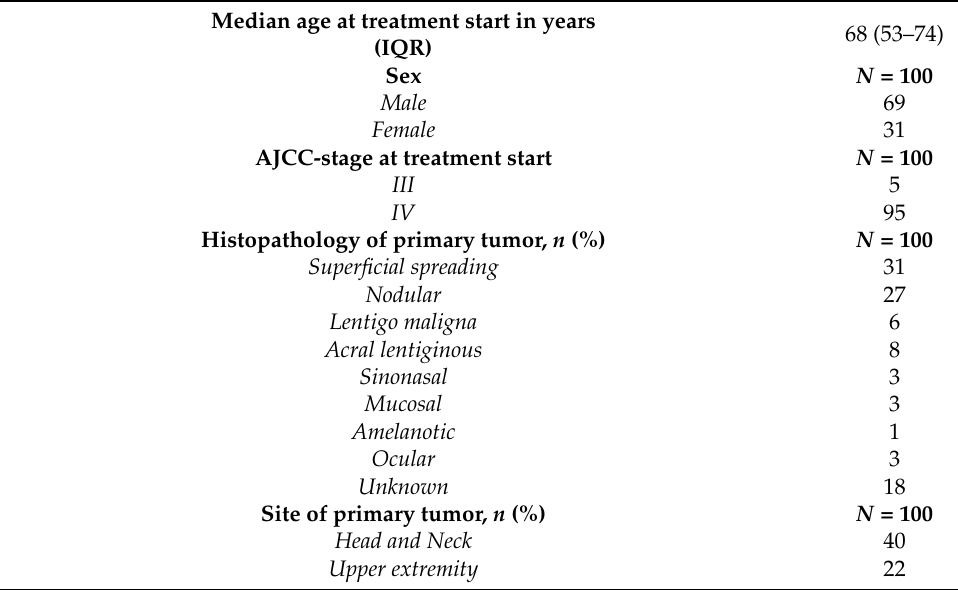
Table 1. Patient characteristics before initiation of immune checkpoint